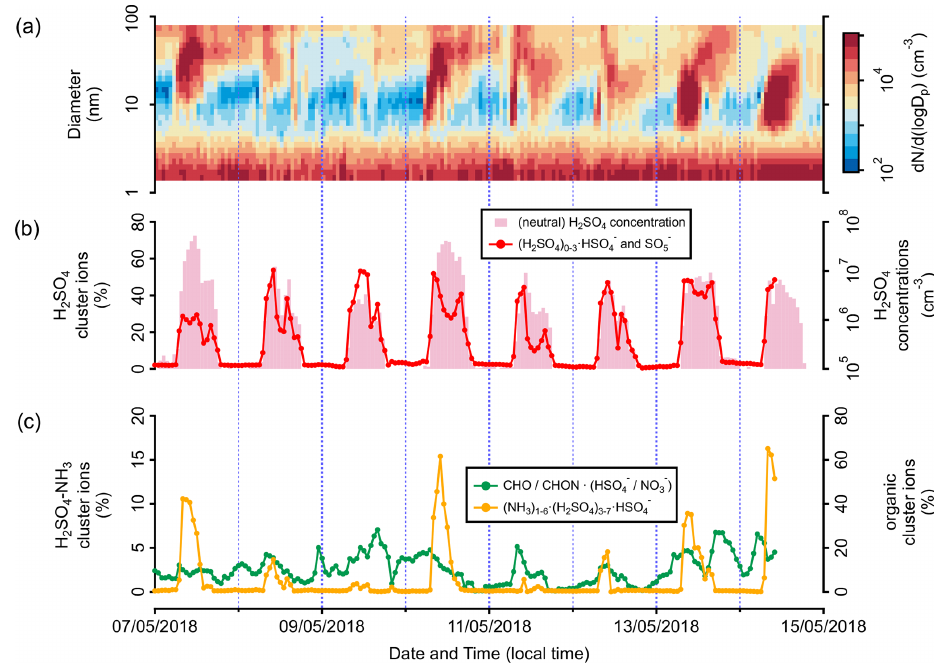
Figure 10. Time series of the (a) size distribution of aerosol particles (measured with NAIS and MPSS), (b) signal fractions of the (cid:113) (H 2 SO 4 ) 0–3 HSO − ion group and neutral H 2 SO 4 concentration, and (c) signal fractions of the (NH 3 ) 1–6 4 tive organic cluster ion groups, observed at CHC from 7 to 14 May 2018, when NPF occurred